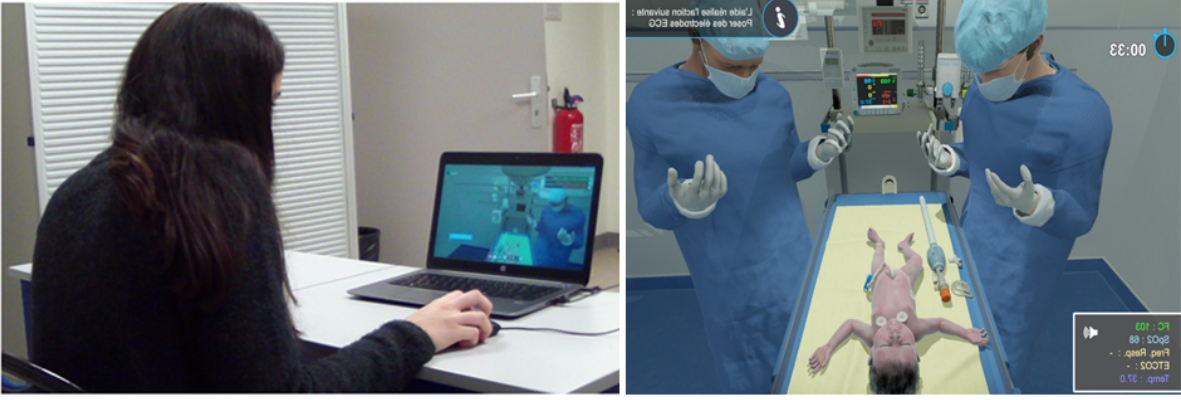
Figure 1. Participant during a scenario on the left and screenshot of the interface and virtual environment of Périnatsims screen-based simulation on the